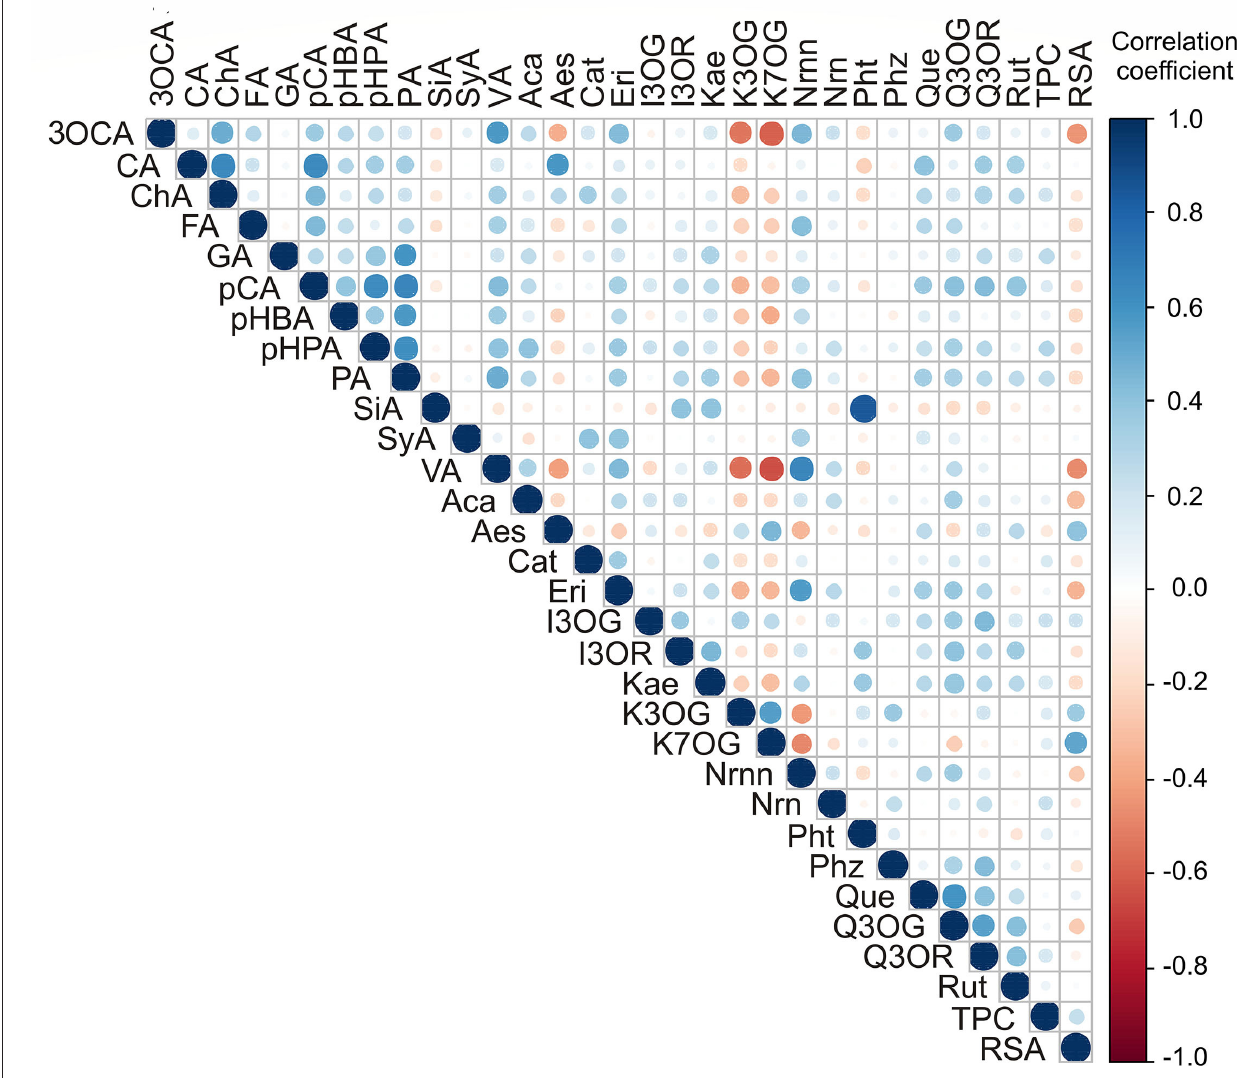
FIGURE 5 | Color correlation graph between phenolic content in apple samples (3OCA, 3- O -caffeoylquinic acid; CA, caffeic acid; ChA, chlorogenic acid; FA, ferulic acid; GA, gallic acid; pCA, p -coumaric acid; pHBA, p -hydroxybenzoic acid; pHPA, p -hydroxyphenylacetic acid; PA, protocatechuic acid, SiA, sinapic acid; SyA, syringic acid; VA, vanillic acid; Aca, acacetin; Aes, aesculetin; Cat, catechin; Eri, eriodictyol; I3OG, isorhamnetin 3- O -glucoside; I3OR, isorhamnetin 3- O -rutinoside; Kae, kaempferol; K3OG, kaempferol 3-O-glucoside; K7OG, kaempferol 7- O -glucoside; Nrnn, naringenin; Nrn, naringin; Pht, phloretin; Phz, phlorizin; Que, quercetin; Q3OG, quercetin 3- O- glucoside; Q3OR, quercetin 3- O- rhamnoside; Rut,